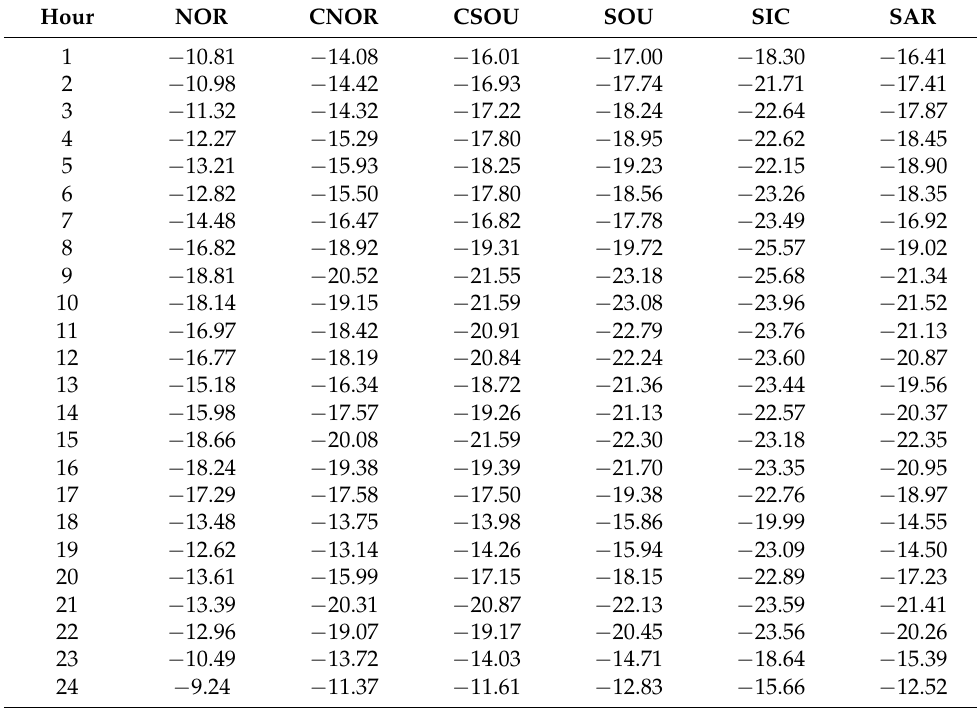
Figure 3. Time series of spot prices observed in the North zone at Noon (12 a.m.). Table 1 shows the unit root test (Phillips–Perron), for each zone of the market and for all settlement periods of the day. Figure 4 displays the autocorrelation function until lag 120 of the level of prices observed in each zone in the middle of the day. Plots in each hour of the day are very similar and are not shown for lack of space. The test always rejects the presence of a unit root, while from the ACF plots weekly seasonality is evident. This seasonality is captured in the RF specification by the number-of-day variable, and by harmonics in the other models. Models could be estimated on first differences to check for robustness. However, as the results on unit root are very clear, we decided to avoid this analysis, to stay focused on the main goal of the paper. Table 1. Phillips–Perron unit root test with constant and trend. The test statistics are shown for each hour and zone. The 99% critical value is −